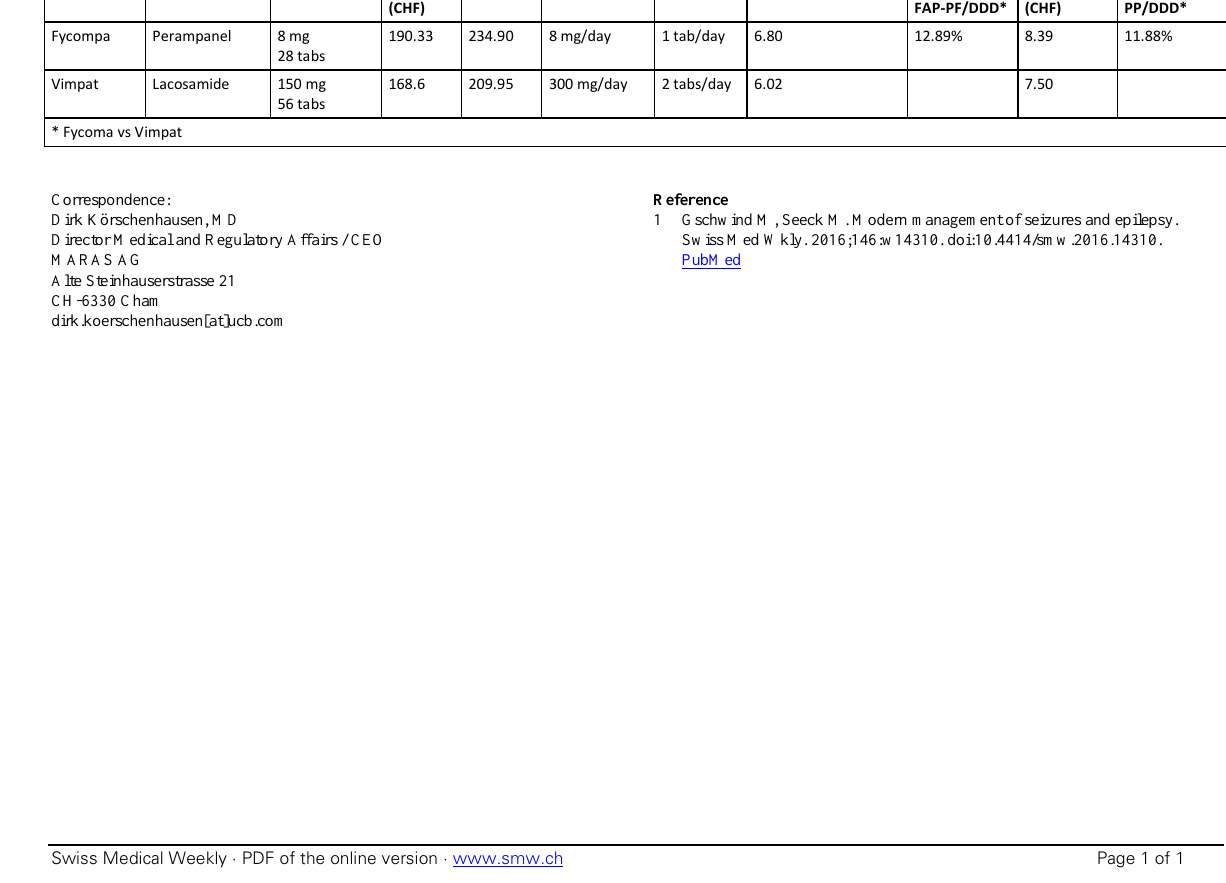
Table 1: Fycompa and Vimpat price (source: Spezialitätenliste (SL) https://bag.e-mediat.net/SL2007.Web.External/ShowPreparations.aspx) Product Molecule Pack size FAP-PF PP (CHF) (CHF)